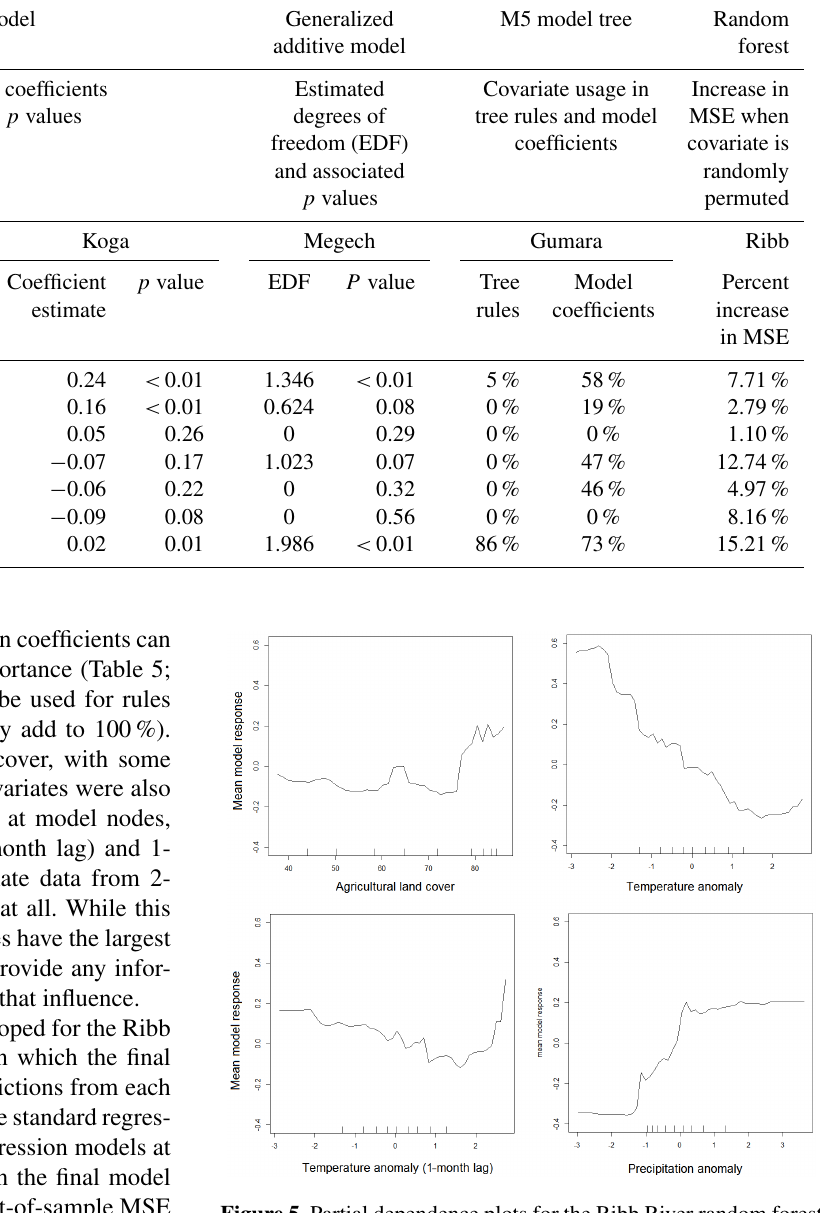
Figure 5. Partial dependence plots for the Ribb River random forest model. Hash marks along the x axis show covariate sample decile